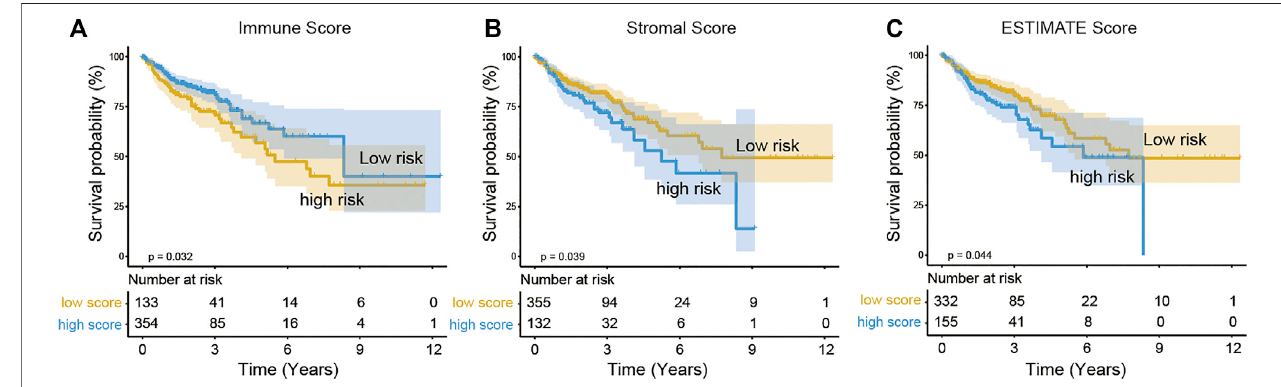
FIGURE 1 | Association of immune scores (A), stromal scores (B), and ESTIMATE scores (C) with COAD overall survival. The COAD cases were divided into two groups based on their immune scores or stromal scores or ESTIMATE scores. Kaplan – Meier survival curve of OS between high and low immune/stromal/ESTIMATE score